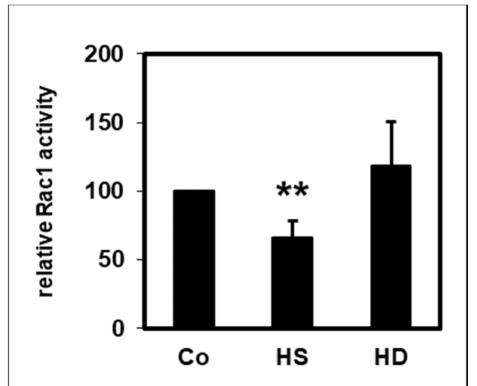
Figure 5. Effect of HDL (10 µ g/mL) from healthy subjects (HS), n = 9 and HD patients (HD), n = 7, on the basal Rac1 activity of PMNLs from healthy subjects. The activity in the absence of HDL was set as 100%. ** p < 0.01 versus control; data shown are mean values ±